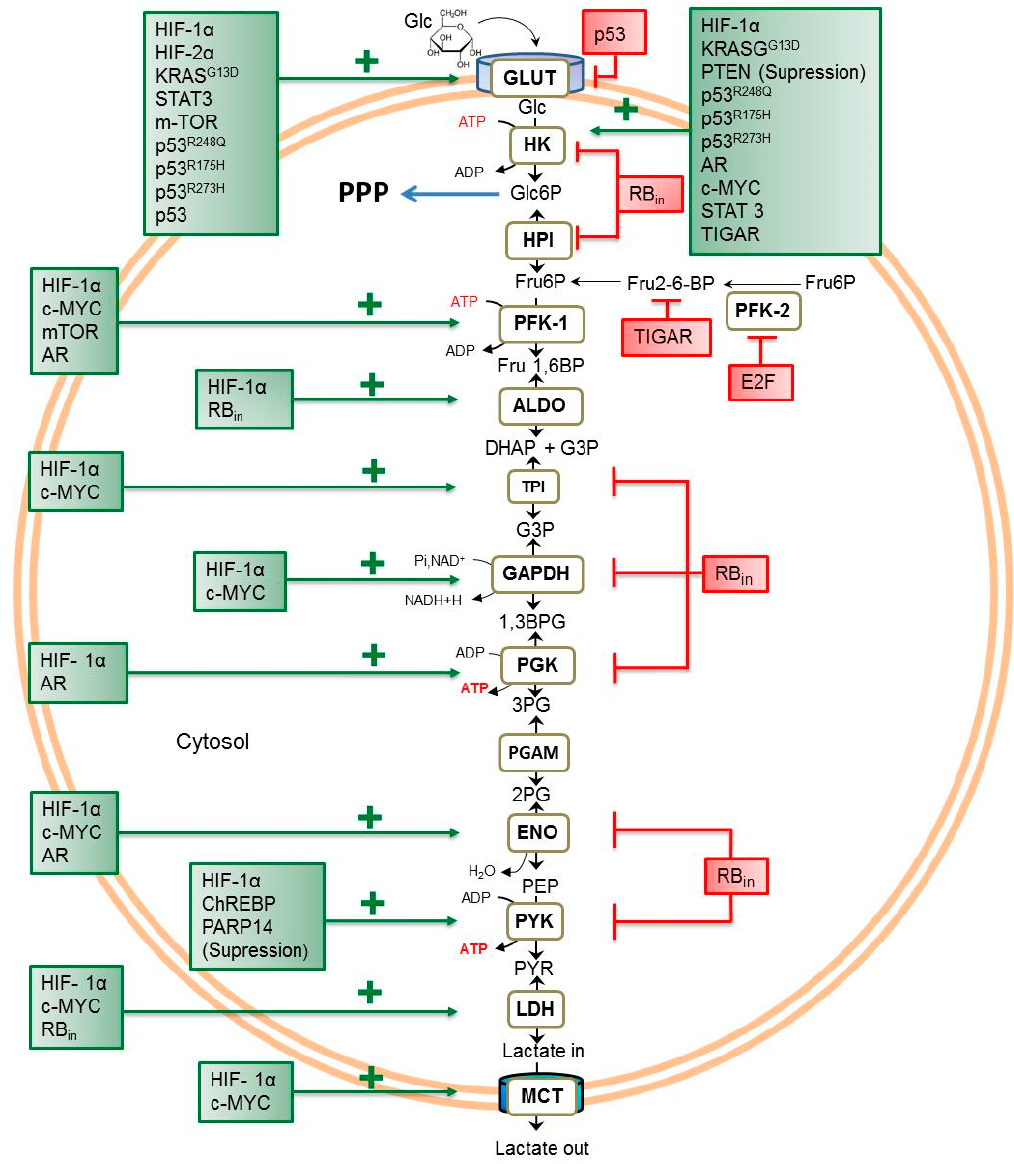
Figure 1. Transcription regulators (TRs) that modulate glycolytic metabolism in cancer cells. Red boxes and lines represent TRs with inhibitory effects, and green boxes and arrows represent TRs with activation effects. Abbreviations: 1,3BPG, 1,3-bisphosphoglycerate; 2PG, 2-phosphoglycerate; 3PG, 3-phosphoglycerate; ALDO, aldolase; DHAP, dihydroxyacetone phosphate; ENO, enolase; Fru1,6BP, fructose1,6-bisphosphate; Fru6P, fructose6-phosphate; G3P, glyceraldehyde-3-phosphate; GAPDH, glyceraldehyde-3-phosphate dehydrogenase; Glc, glucose; Glc6P, glucose6-phosphate; GLUT, glucose transporter; HK, hexokinase; HPI, hexose phosphate isomerase; LDH, lactate dehydrogenase; MCT, monocarboxylate transporter; PEP, phosphoenol pyruvate; PFK1, phosphofructokinase type 1; PGAM, phosphoglycerate mutase; PGK, phosphoglycerate kinase; PPP, pentose phosphate pathway; PYK, pyruvate kinase; PYR, pyruvate; TPI, triosephosphate isomerase.